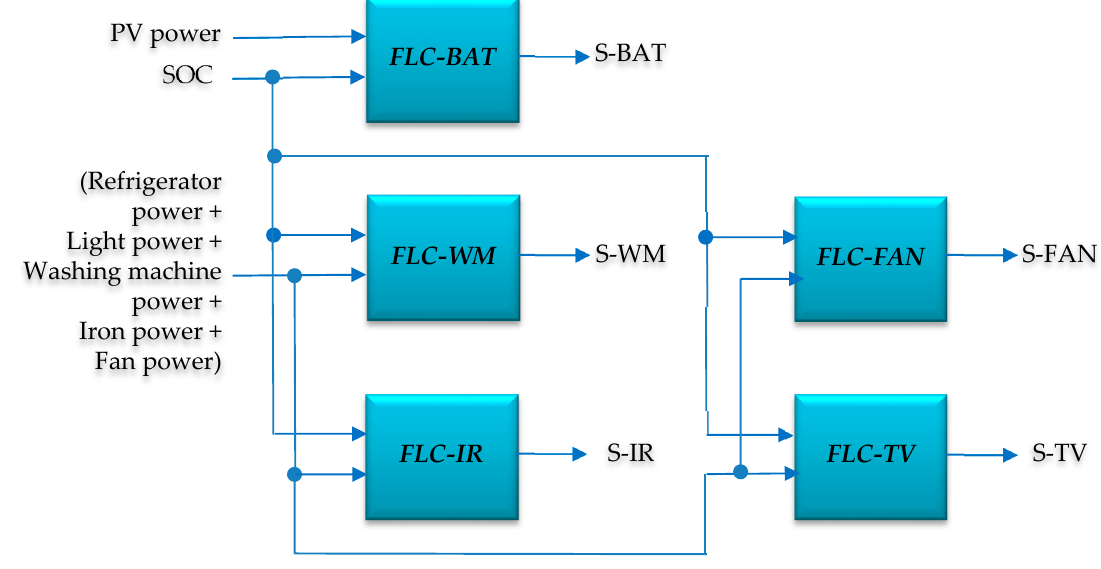
Figure 2. The architecture of the proposed FLC.